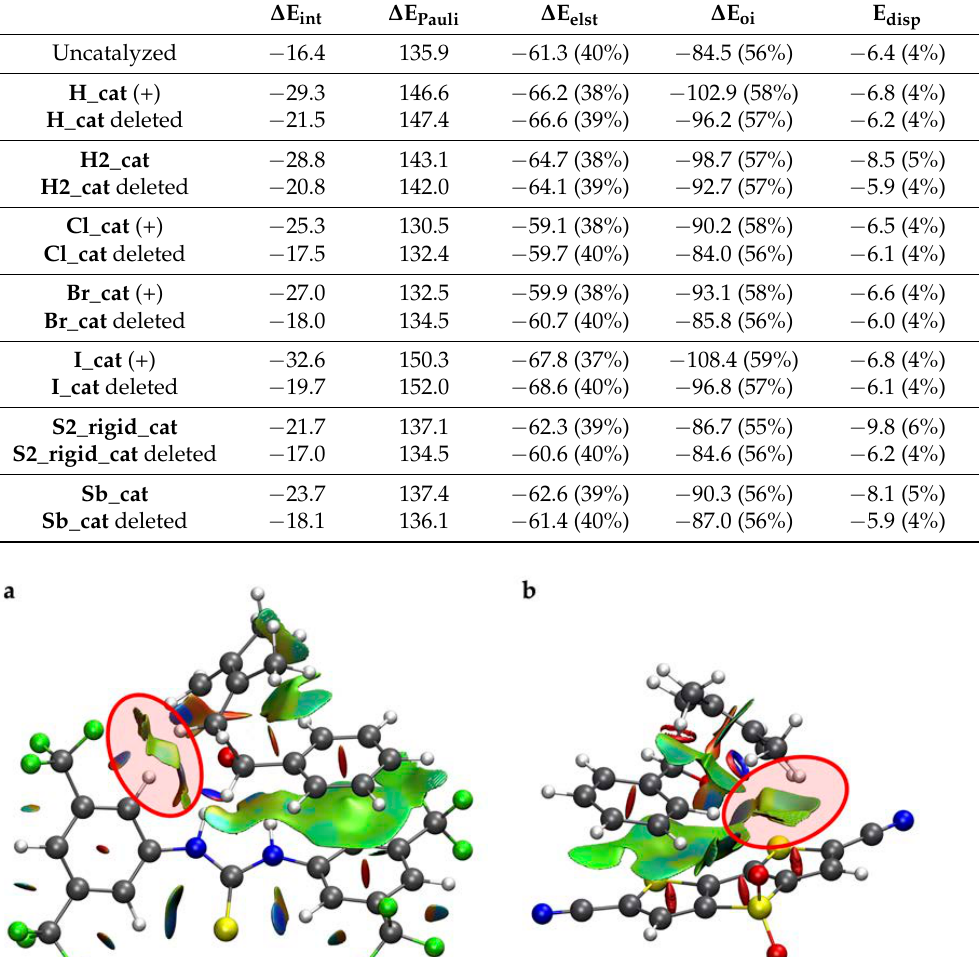
Table 5. EDA analysis of the transition state for the uncatalyzed and non-covalently catalyzed reactions between benzaldehyde and 2,3-dimethyl 1,3-butadiene, the latter in the presence and absence of the catalyst. All values are given in kcal mol − 1 . The values in brackets represent the relative contribution of the given energies to the stabilizing part of the total interaction energy.